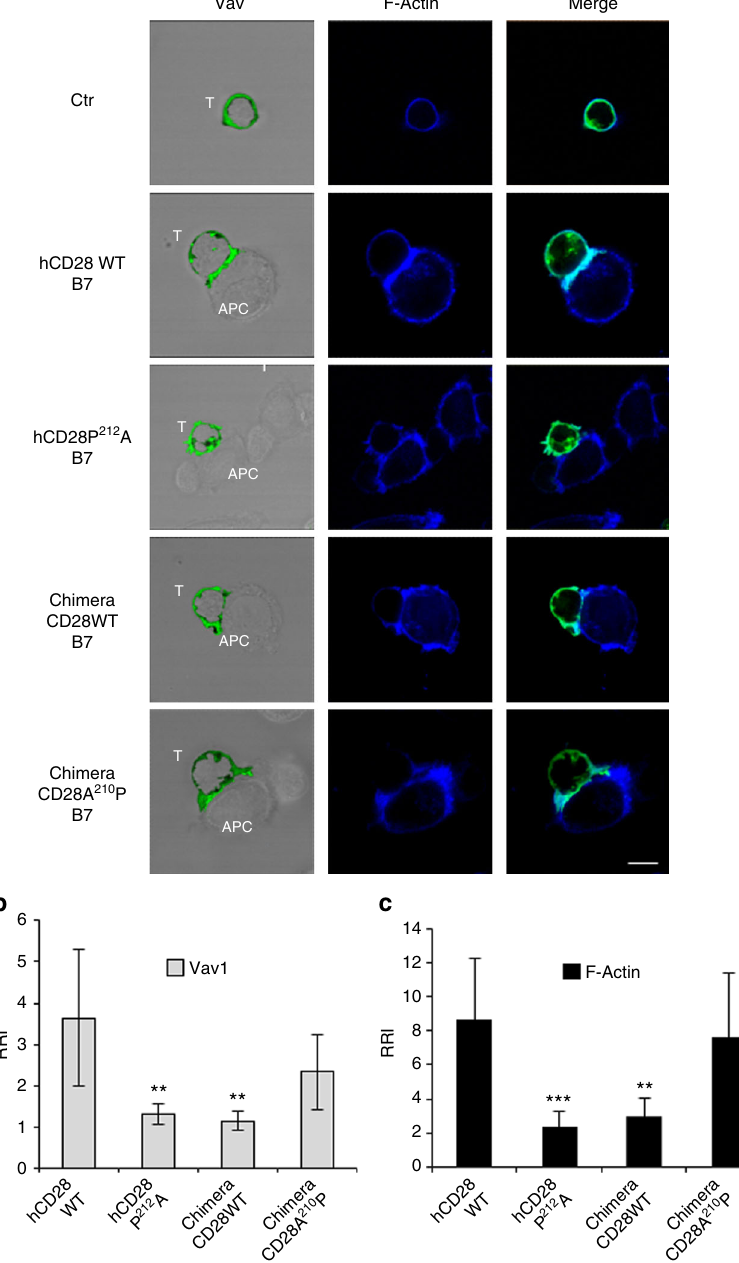
Fig. 6 P 212 within the C-terminal proline-rich motif of human CD28 is essential for Vav1 recruitment and actin polymerisation. a hCD28 WT or hCD28P 212 A or chimera containing the extracellular and transmembrane domain of human CD28 and the cytoplasmic tail of mouse CD28 (Chimera CD28WT) or mouse CD28 mutant (Chimera CD28A 210 P) were transfected with 20 μ g of GFP-Vav1 (green) and then stimulated for 15 min in the absence (Ctr) or presence of Dap/B7 cells (B7). After fi xing and permeabilisation F-actin was stained with 633-conjugated phalloidin (blue) and analysed by confocal microscopy. The scale bar represents 10 μ m. b , c The relative recruitment index (RRI) of Vav1 ( b ) and F-actin ( c ) was calculated as described in Methods and represents the mean ± SD of 15 conjugates analysed in each group. Mean values: Vav, hCD28WT = 3.6 ± 1.6, hCD28P 212 A = 1.3 ± 0.24, Chimera CD28WT = 1.14 ± 0.2, Chimera CD28A 210 P = 2.33 ± 0.9; F-actin, hCD28WT = 8.65 ± 3.6, hCD28P 212 A = 2.2 ± 0.9, Chimera CD28WT = 2.9 ± 1, Chimera CD28A 210 P = 7.6 ± 3.8. Asterisks ** p < 0.01, *** p < 0.001 calculated by Student ’ s t- test compared with hCD28WT. The results are representative of